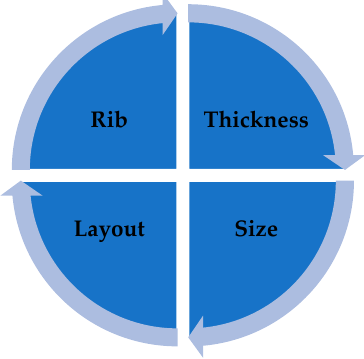
Figure 19. Parameter of cushion design.